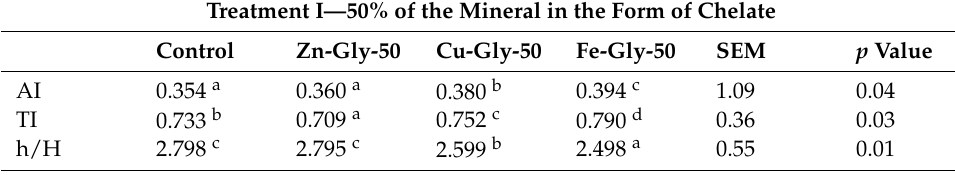
Table 7. Dietetic values of thigh-meat